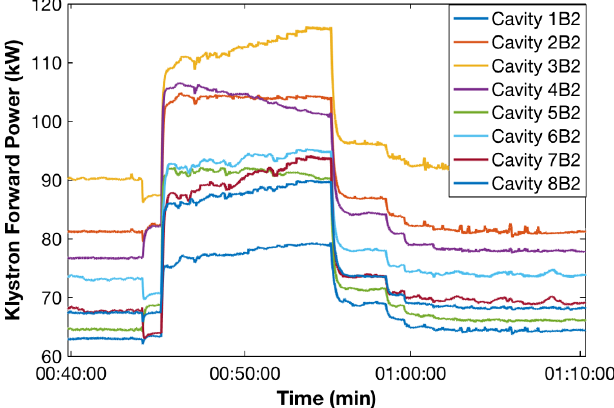
FIG. 9. Average klystron forward power. 1164 bunches, beam 2.